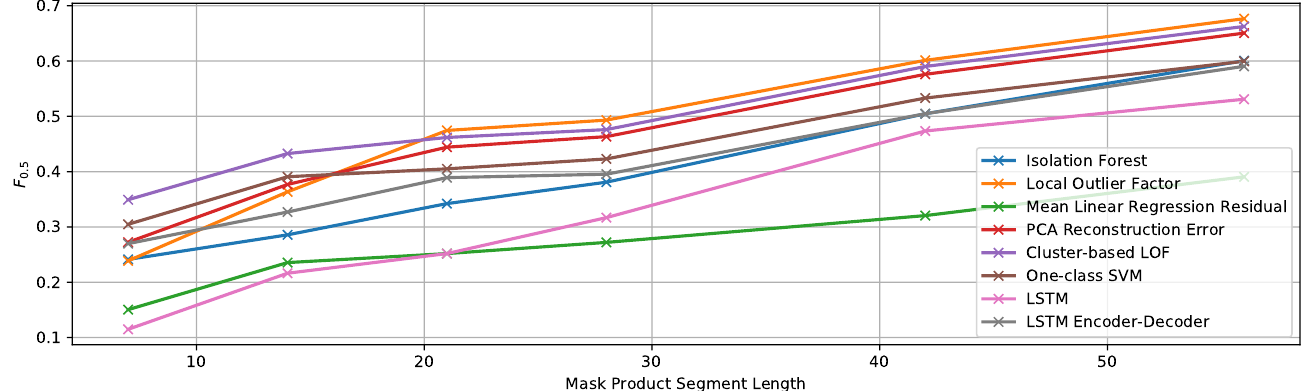
Figure 12. F 0.5 score of the multivariate detection methods using the true contamination value for experiment